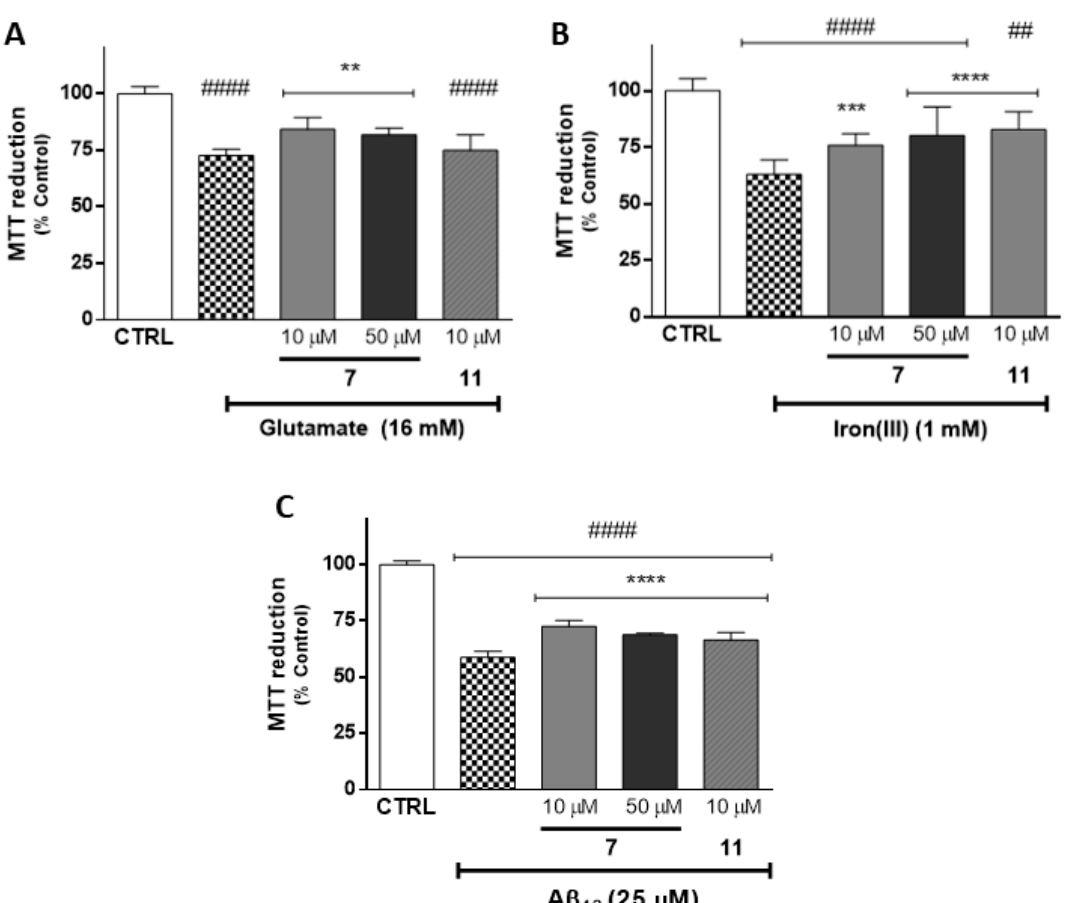
Figure 6. Evaluation of the protective e ff ects of Compounds 7 (10 and 50 µ M) and 11 (10 µ M) in SH-SY5Y cells against glutamate (16 mM, A ), iron(III) (1 mM, B ) and A β 42 (25 µ M, C ) as oxidative stress inducers. The cells were pre-treated with antioxidants for 30 min and exposed to the aggressors for 24 h. The data are expressed as the means of three independent experiments together with the standard deviation (Mean ± SD). Statistical comparisons were estimated using the nonparametric method of Kruskal–Wallis [one-way ANOVA on ranks] followed by Dunn’s post hoc test ( A , B ) and using the parametric method of one-way analysis of variance (ANOVA) followed by Dunnett’s multiple comparison test ( C , F = 364.2) (Supplementary Table S2). In all cases, p values lower than 0.05 were considered significant ( ## p < 0.05, #### p < 0.0001 vs. control data; ** p < 0.01, *** p < 0.001, **** p < 0.0001 vs. aggressor values).